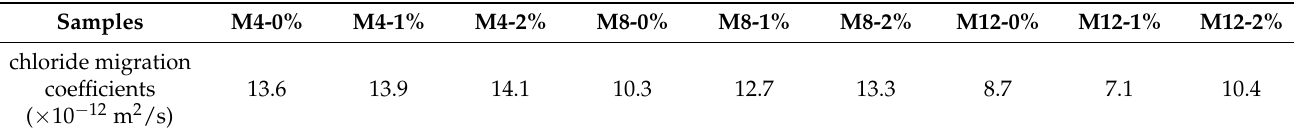
Table 4. Average non-steady chloride migration coefficients for each group of